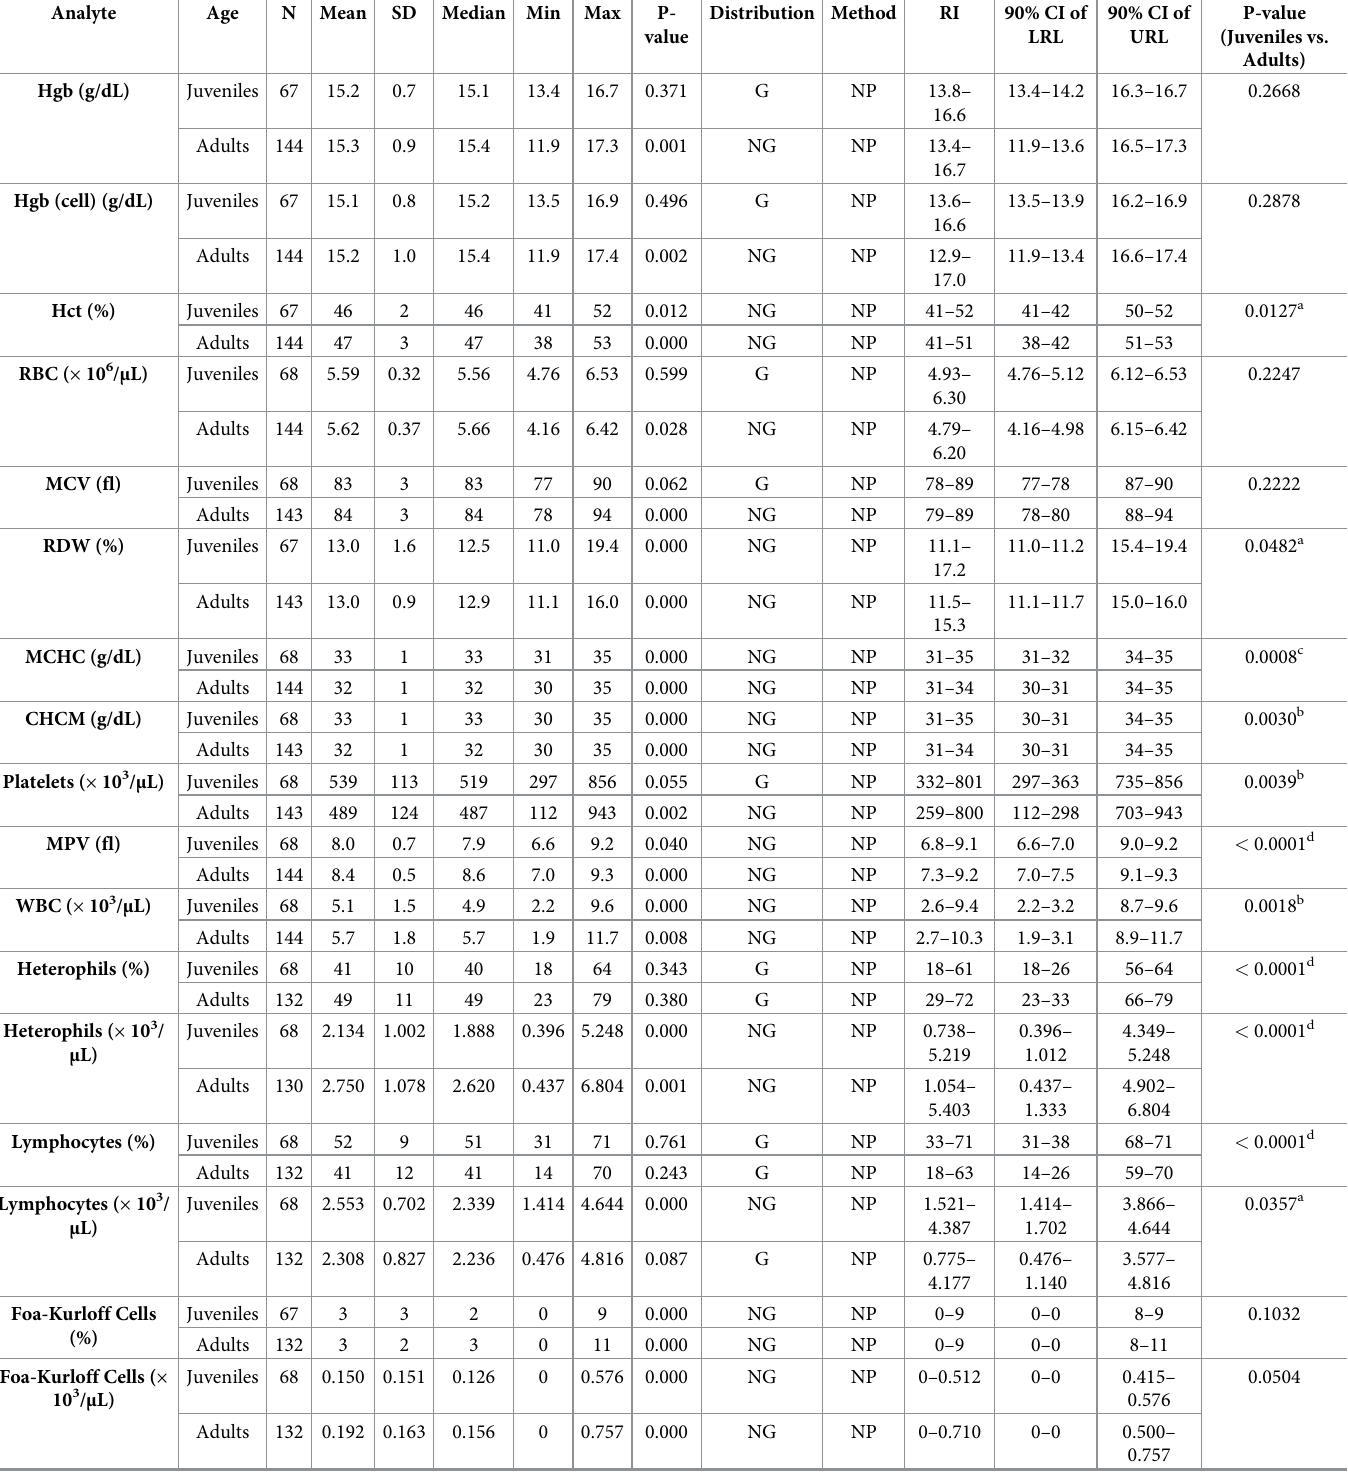
Table 1. Summary data and reference intervals for hematology parameters of juvenile ( < 5 mo) and adult ( � 5 mo) Hartley guinea